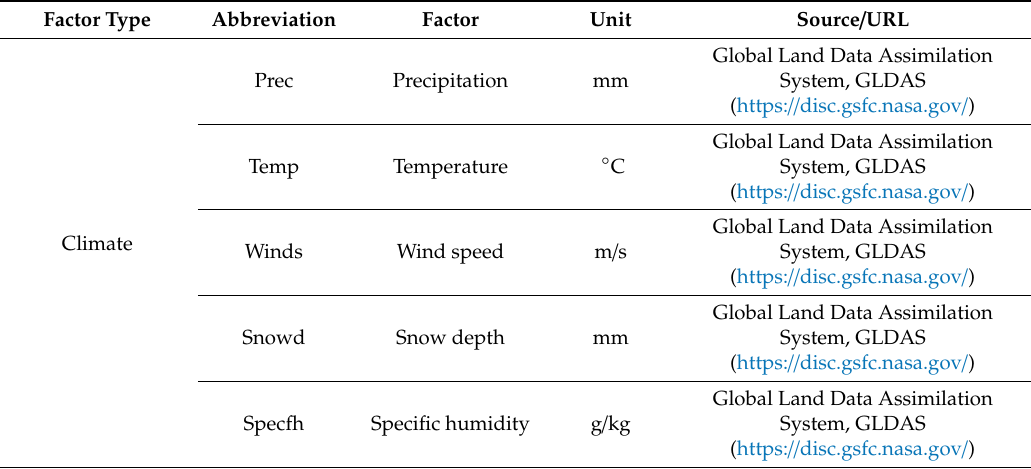
Table 1. Index of the environmental factors applied for analysis.